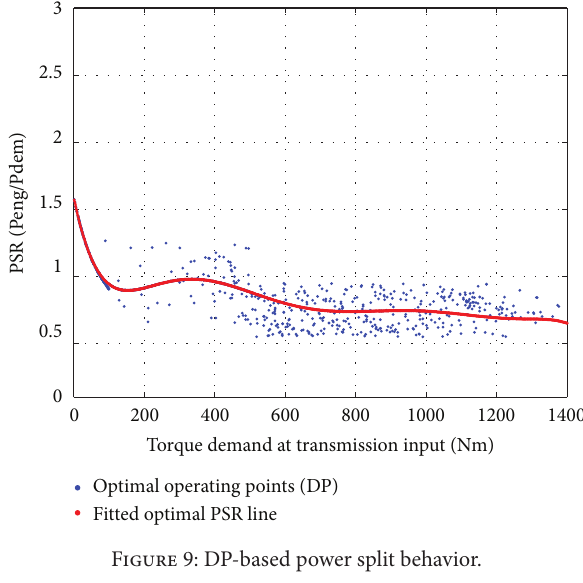
Figure 9: DP-based power split behavior.